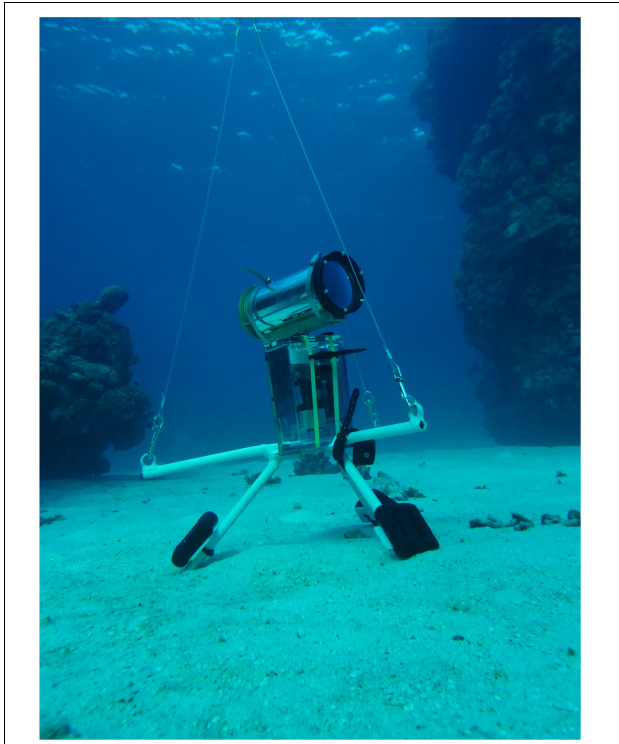
FIGURE 1 | The STAVIRO lander on a sandy bottom in New Caledonia. Credits: B. Preuss – Ifremer AMBIO